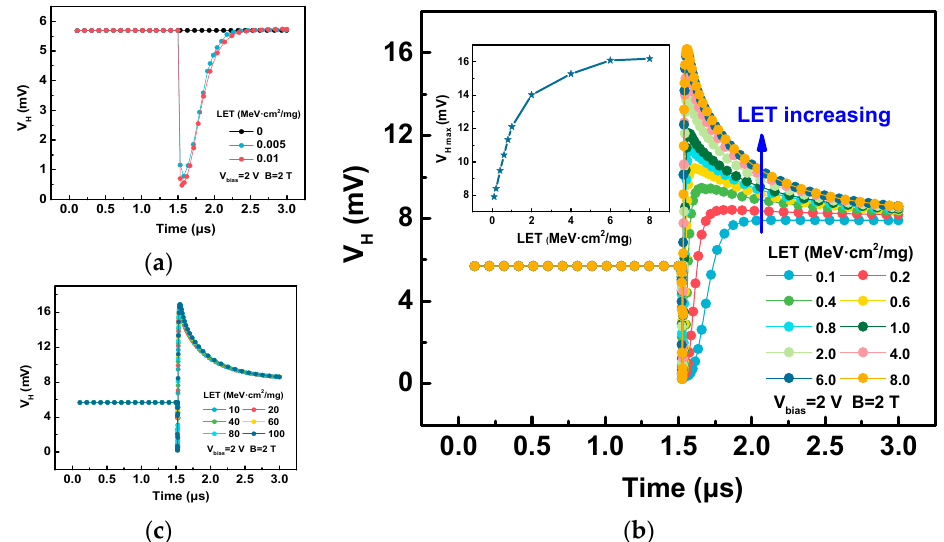
Figure 9. Time variations of the Hall voltages ( V H ) with ( a ) low, ( b ) medium, and ( c ) high LETs. The inset in ( b ) is the change in maximum Hall voltage ( V H max ) with LETs.